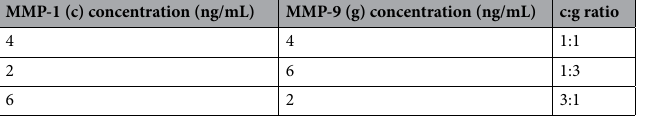
Table 1. Concentration ratios of enzymes used to degrade articular cartilage